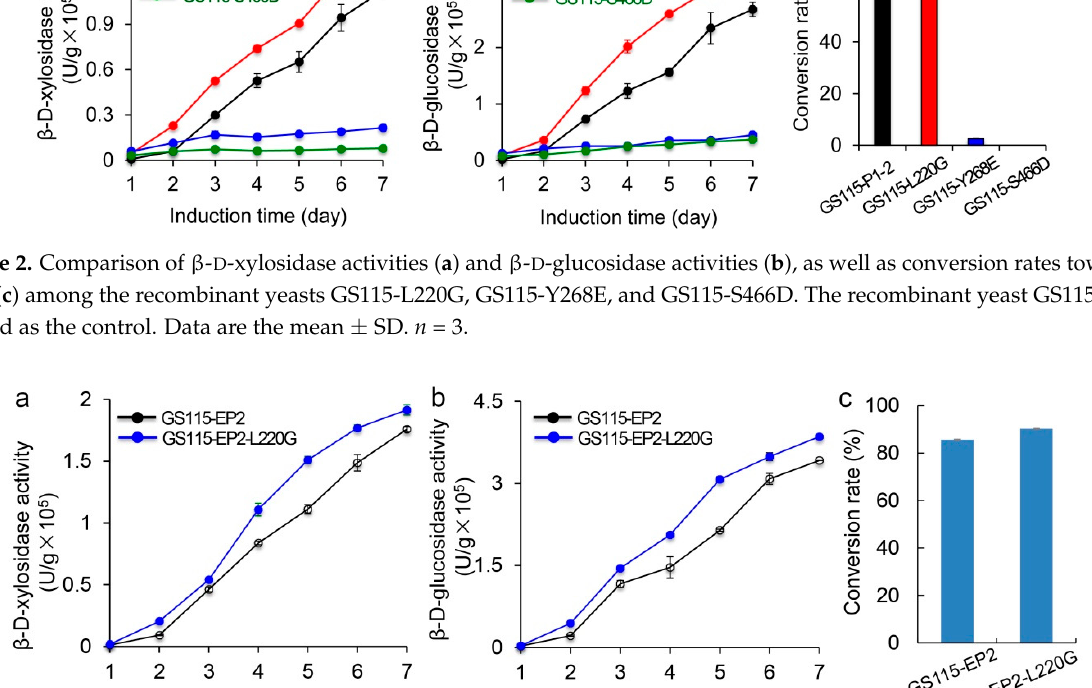
Figure 2. Comparison of β -D-xylosidase activities ( a ) and β -D-glucosidase activities ( b ), as well as conversion rates to- wards XDT ( c ) among the recombinant yeasts GS115-L220G, GS115-Y268E, and GS115-S466D. The recombinant yeast GS115-P1-2 is used as the control. Data are the mean ± SD. n=3.